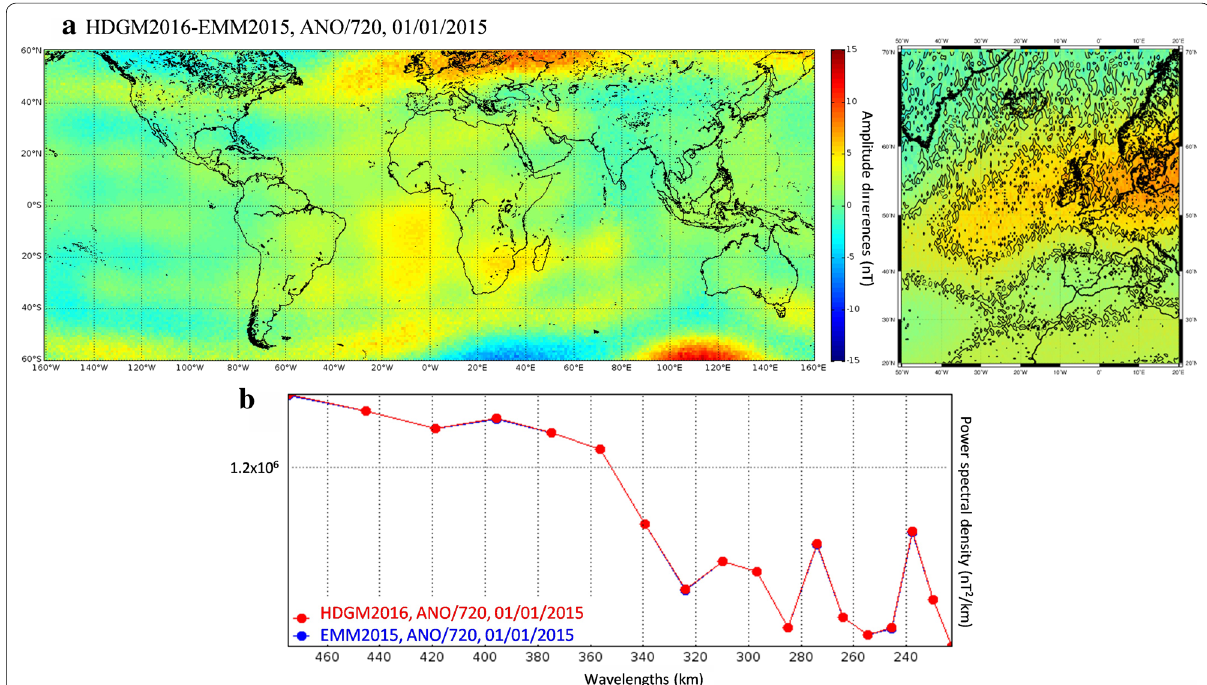
Fig. 6 Comparison of intensity values of the anomaly field (ANO) estimated from HDGM2016 and EMM2015 up to SH degree 720 for the date 01/01/2015. a Maps of differences at a global scale reduced by 30° in latitude and 20° in longitude (left, grid spacing: 1°) and for the NEAWM area (right, grid spacing: 0.5°). b Radial power spectral densities at a reduced global